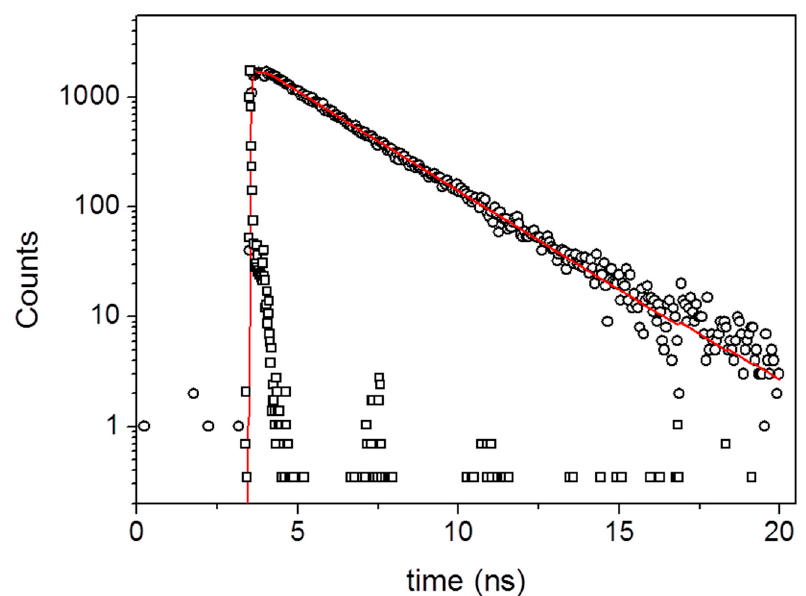
Figure 4. Fluorescence decay obtained from sample under lipase hydrolysis of QDA 2.0 × 10 − 5 mol ∙ L − 1 in hexane ( λ exc = 400 nm, λ em = 550 nm, 20 mg of Novozym 435, T = 298 K). Fluorescence lifetime of 2.3 ns and fitting chi-square χ 2 = 1.041.